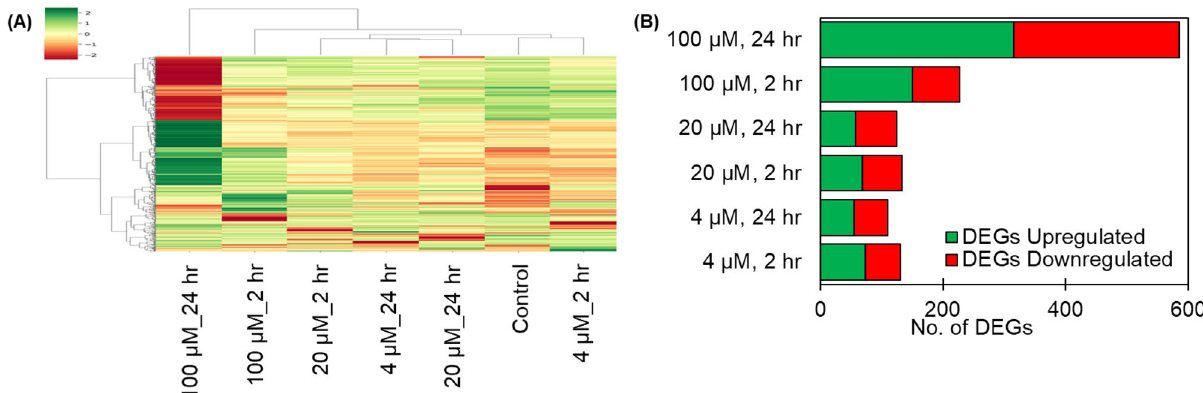
Figure 2. Differentially expressed genes in RNA-seq experiment. (A) Unsupervised hierarchical clustering heatmap of DEG expression based on z-score data of RNA-seq transcriptome. Each column represents an experimental condition and each row represents a single gene. Green means upregulation and red means downregulation. The vertical distances on each indicate the degrees of similarity between genes and the horizontal distances on each column indicate the degrees of similarity between the experimental groups. (B) Number of DEGs in each comparison condition. The vertical axis corresponds to the experimental comparison groups, and the horizontal axis displays the number of DEGs.